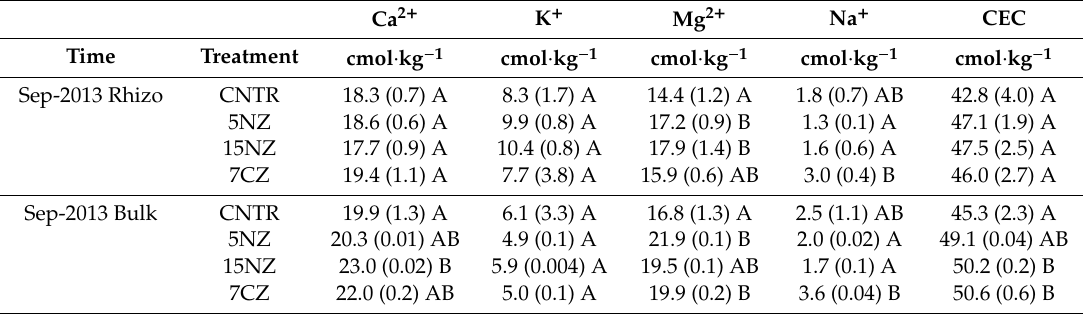
Table 2. Average of exchangeable bases and cation exchange capacity (CEC) of soil samples, both bulk soil and rhizosphere. Standard deviation within brackets. Significant ( p < 0.05) or non-significant ( p > 0.05) di ff erences between treatments at each sampling time are indicated by capital letters. Ca 2 + K + Mg 2 + Na + CEC Time Treatment cmol · kg − 1 cmol · kg − 1 cmol · kg − 1 cmol · kg − 1 cmol · kg − 1 Sep-2013 Rhizo CNTR 18.3 (0.7) A 8.3 (1.7) A 14.4 (1.2) A 1.8 (0.7)